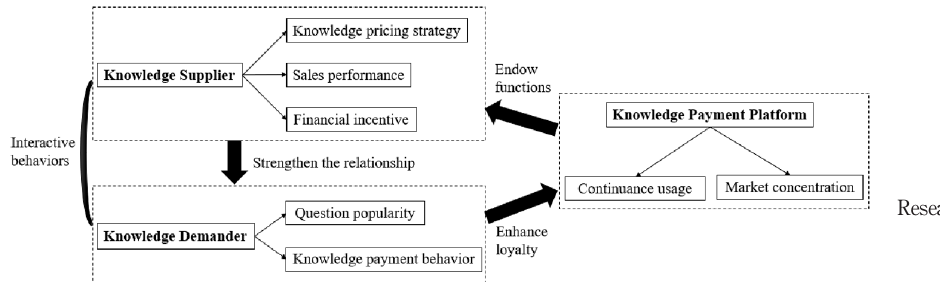
Figure 2. Research